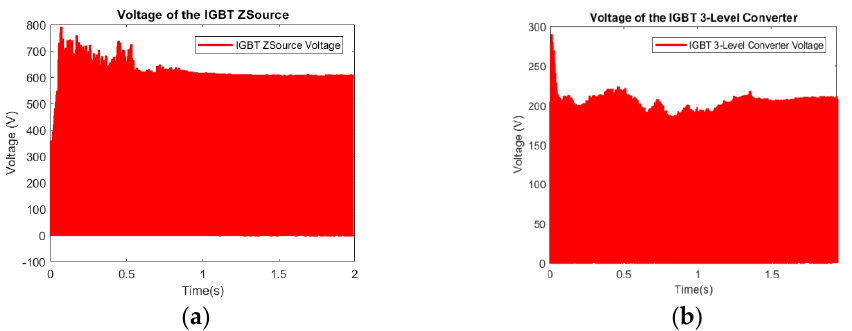
Figure 15. Voltage stresses applied in ( a ) the Z-source ST module and ( b ) one IGBT switch of the 3-level DC/DC converter.